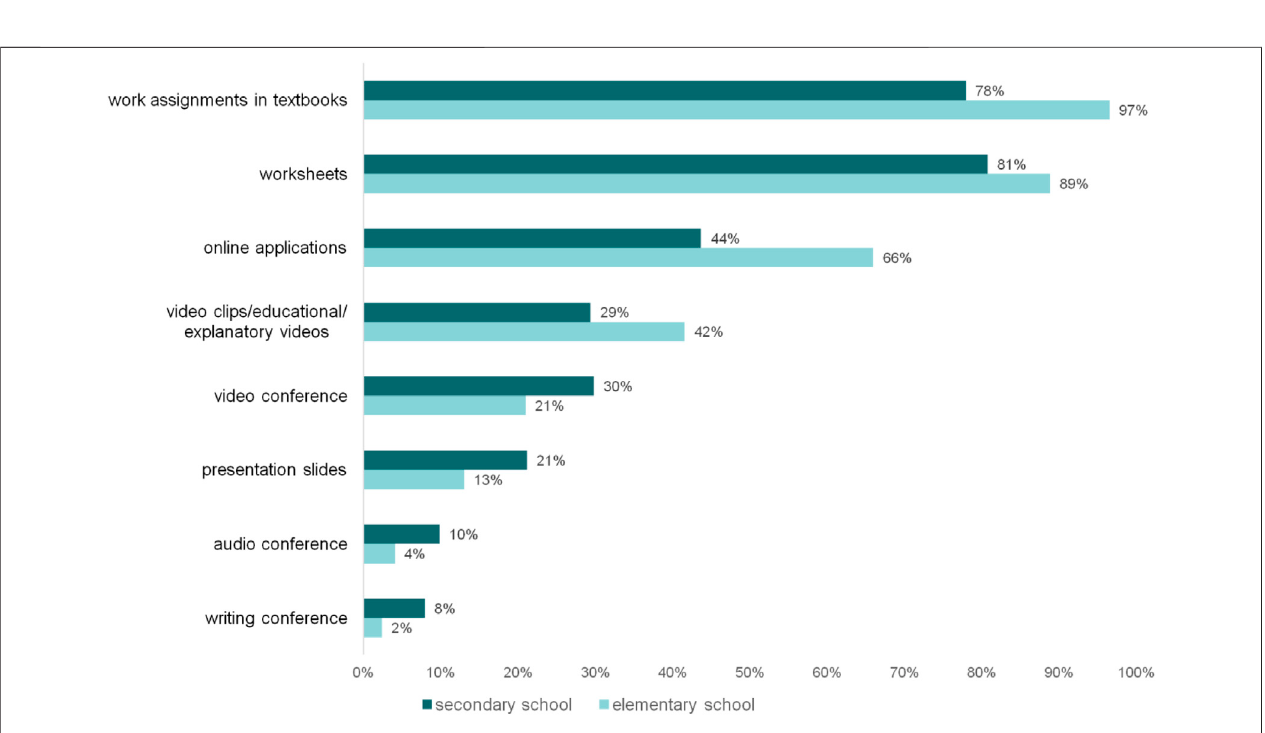
Frontiers in Education |